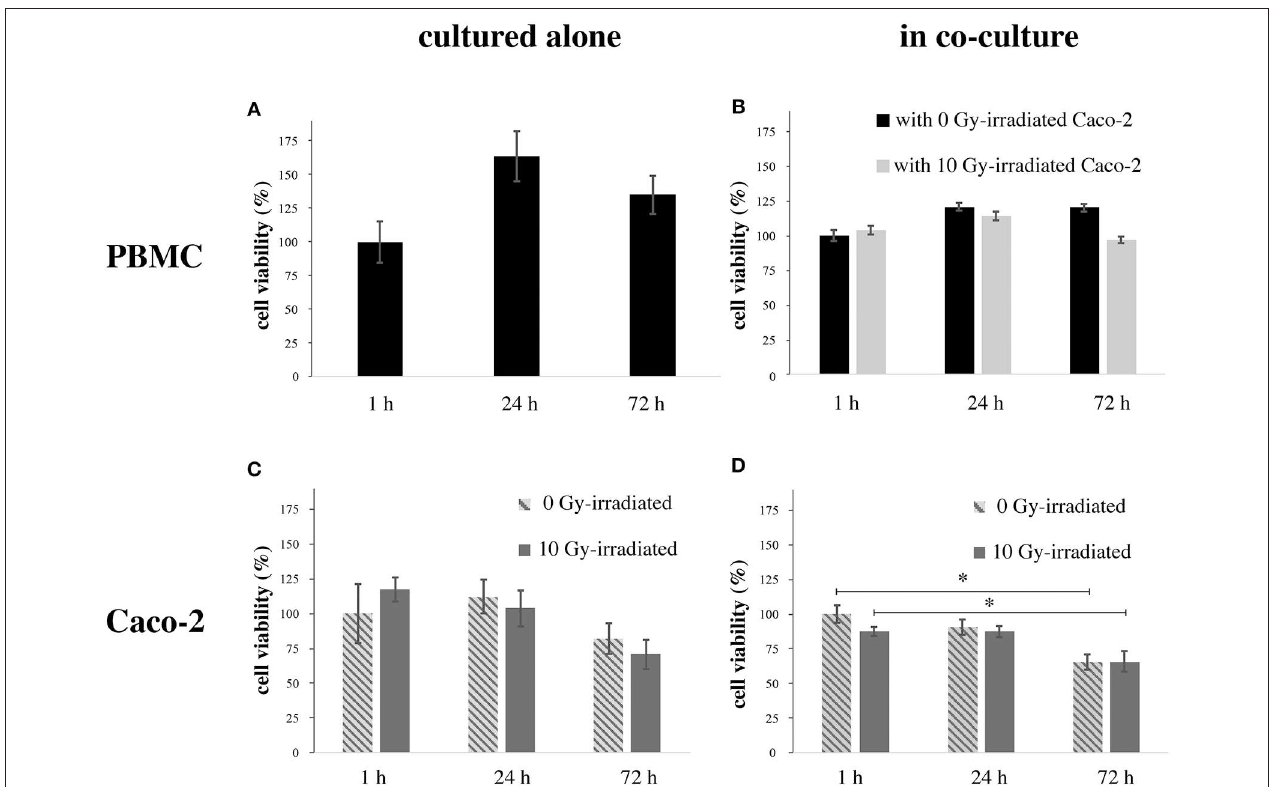
FIGURE 2 | Viability (MTT) in PBMCs and Caco-2 cells as a function of time. (A) PBMCs cultured alone, normalized to the 1h time-point; (B) PBMCs co-cultured with sham- or 10 Gy-irradiated Caco-2 cells, normalized to the 1h time-point when in co-culture with non-irradiated Caco-2. (C) Caco-2, sham- or 10 Gy-irradiated, cultured alone, normalized to the 1h time-point, 0Gy; (D) Caco-2, sham- or 10 Gy-irradiated, in co-culture with PBMCs, normalized to the 1h time-point, 0Gy. Each value is the mean of 9 independent experiments, errors are expressed as SEM. Statistical significance ( p < 0.05) is calculated by two-tailed Student’s t